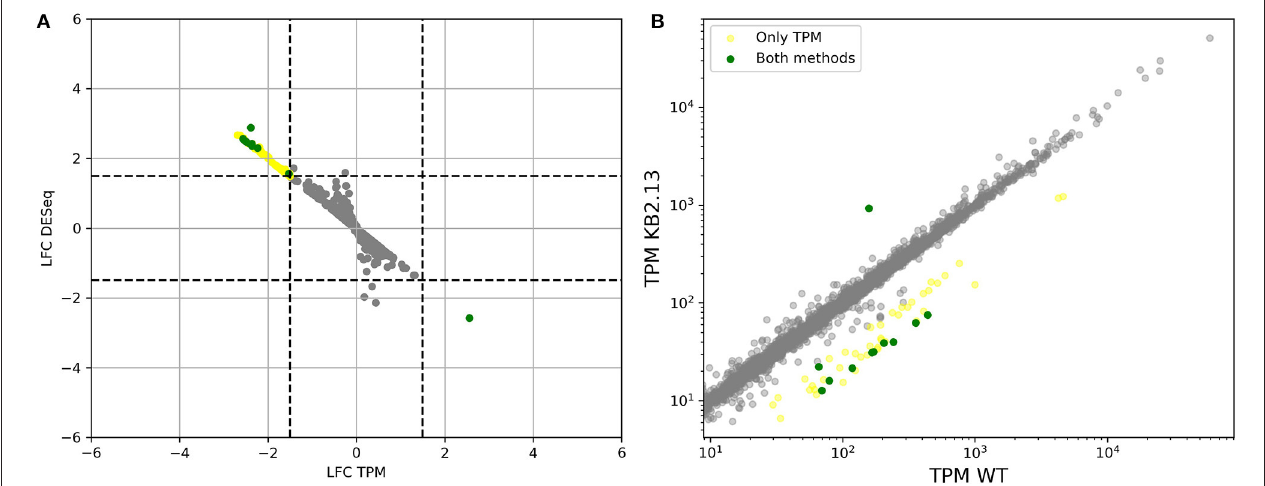
FIGURE 11 | (A) Comparison of log2-fold-changes between wild type and strain KB2.13 obtained using TPM count vs. DESeq. Dashed lines mark the threshold for differential expression. (B) Comparison of TPM counts between wild type and strain KB2.13. Genes that are considered to be differentially expressed by both methods are plotted in green. Only by DESeq in orange and only by TPM count in yellow.